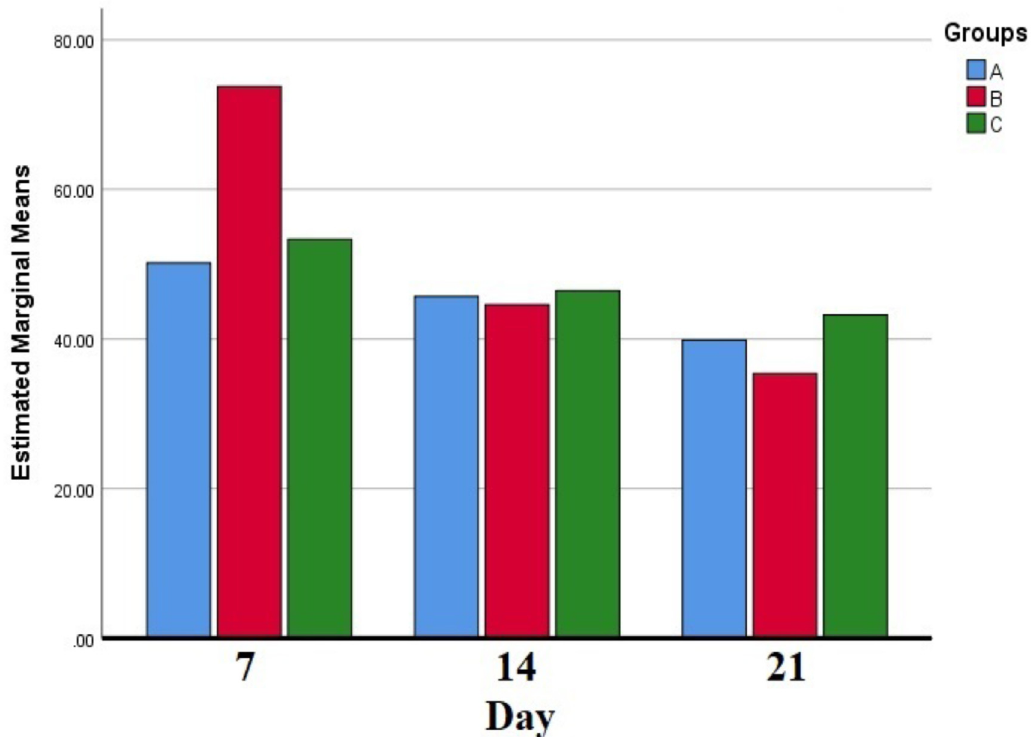
Fig. 5. Estimated marginal means of percentage of fi broblast cells on day 7, 14, and 21.